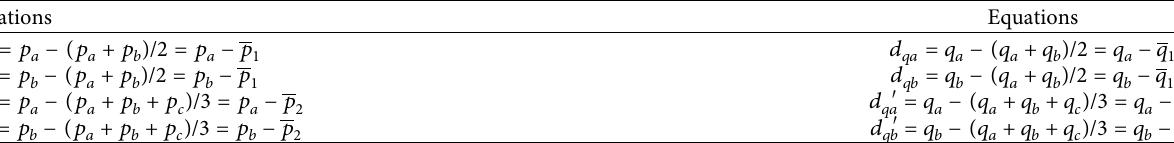
Table 1: The difference between the price/quality and the mean of the product category in scenarios with and without a decoy. Equations Equations